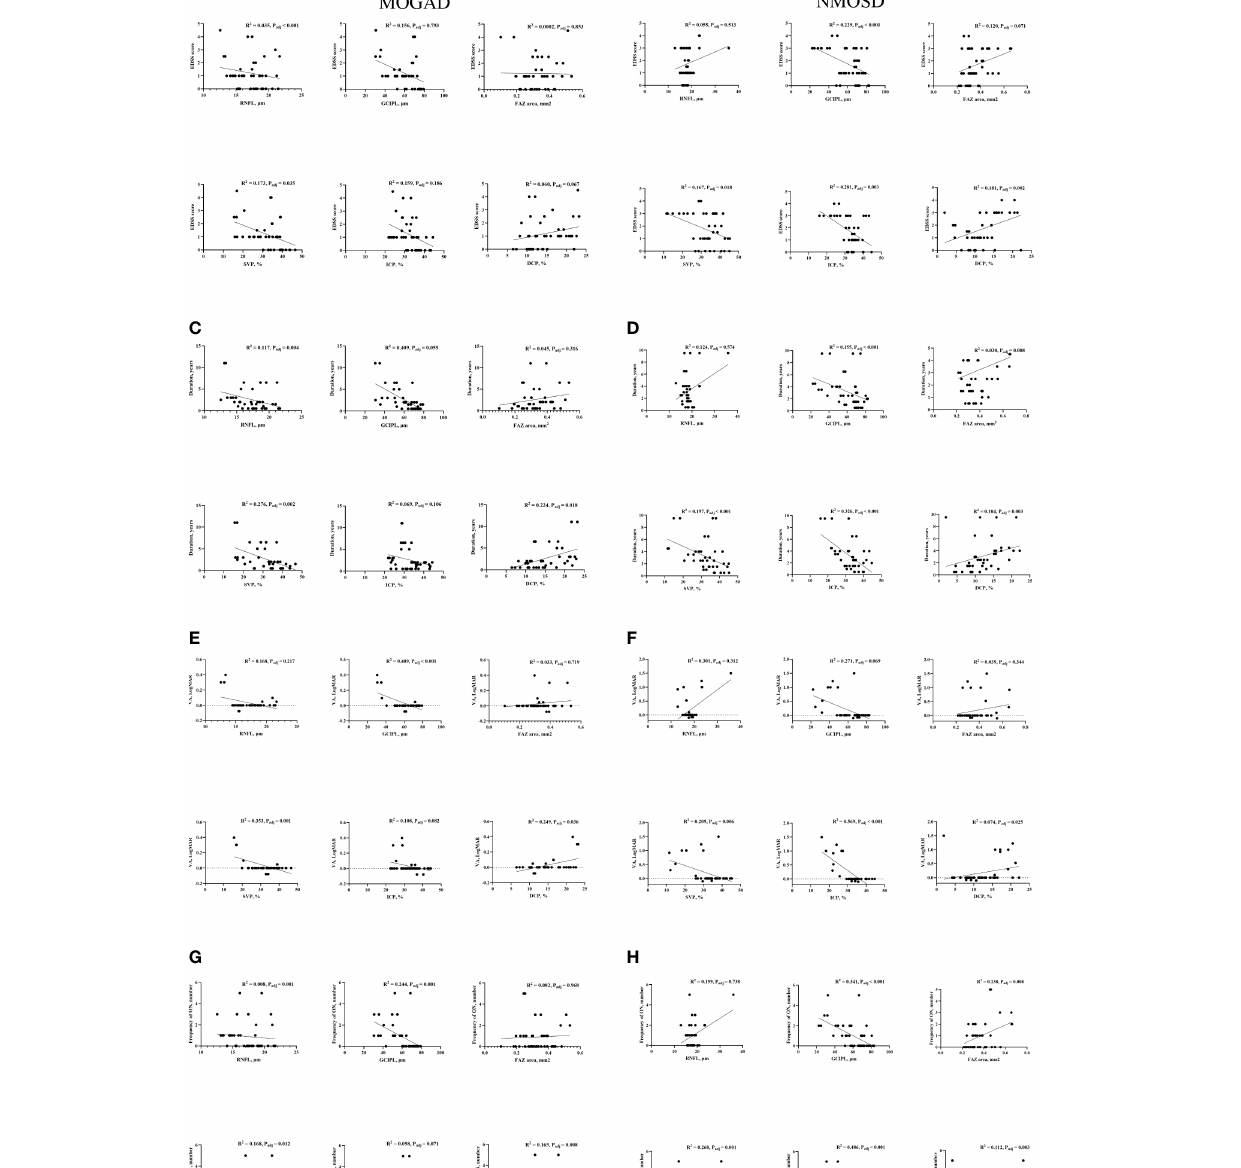
Figure 3. In NMOSD patients, EDSS, disease duration, reduced visual acuity, and frequency of ON correlated ( P < 0.05, Figure 3) with retinal microvascular changes in the three plexuses.